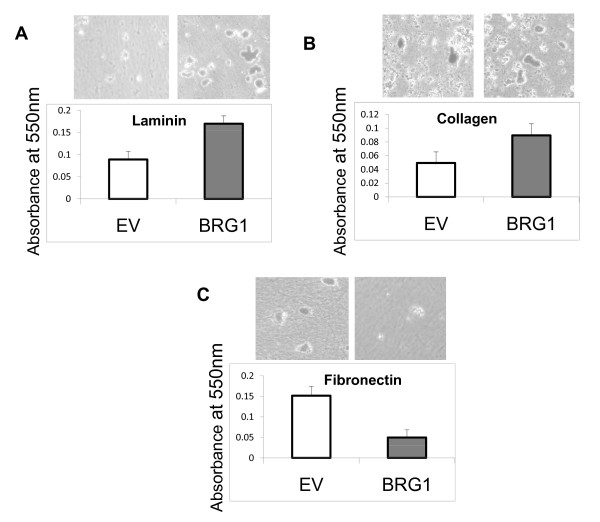
BRG1 expression alters adhesion of SK-MEL5 cells to different ECM components. 96 well plates were coated with laminin, collagen, or fibronectin and blocked with BSA. Control SK-MEL5 cells expressing empty vector (EV) and SK-MEL5 cells expressing BRG1 were seeded onto coated plates at a density of 2 × 104 cells. After incubation for 30 minutes, plates were washed and the cells stained with crystal violet. Control plates coated with BSA were also included but did not retain cells after washing (data not shown). Representative fields are shown (20× magnification). Adhesion was quantified by reading absorbance at 550 nm. The data shown is the average of two independent experiments done in triplicate. The fold change in adhesion to all three substrates was significantly altered by expression of BRG1 (p < 0.01). A. Adhesion to laminin. B. Adhesion to collagen. C. Adhesion to fibronectin.